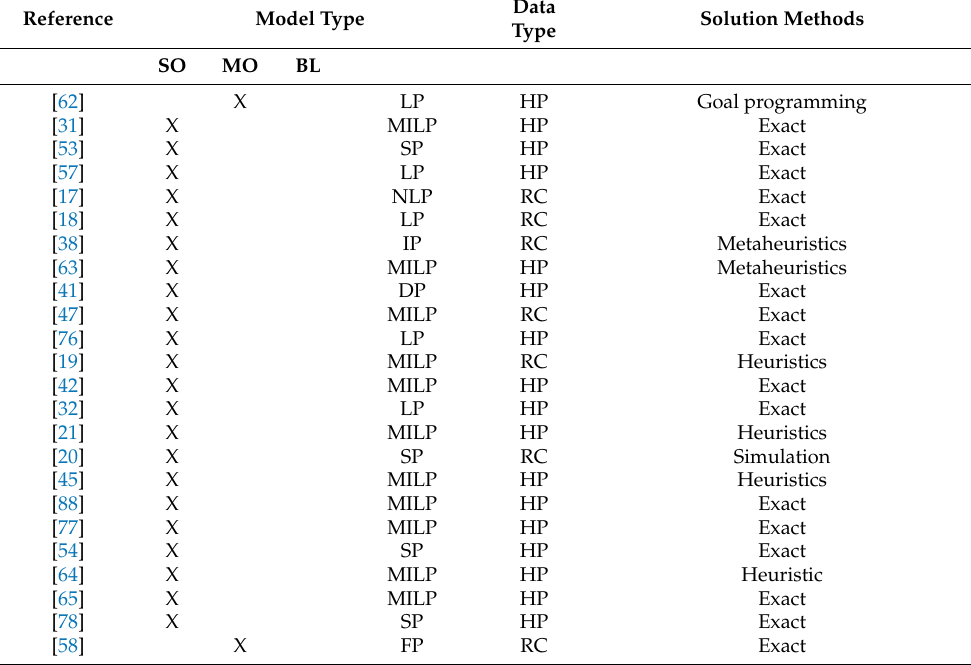
Table 4. Classification according to modeling